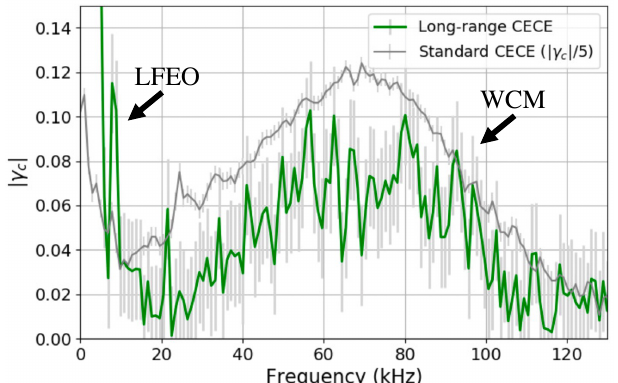
Figure 5. CECE coherency spectra obtained by correlating chan- nels near the WCM location at ρ pol = 0 . 99 from CECE systems toroidally separated by ∼ 60 ◦ (green). CECE coherency spec- tra from standard CECE analysis with neighboring channels in a single system is overlaid in grey, with a normalization factor for clear visualization. The WCM is visible in both the long-range and local